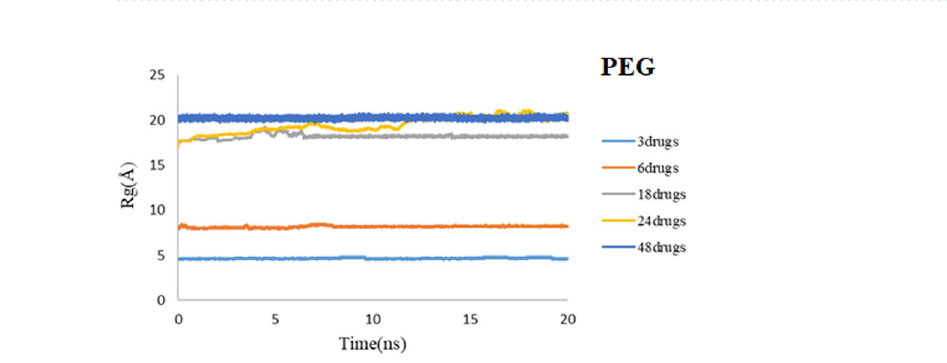
Figure 17. SASA values of 3TC-SiO 2 complex for 3, 6, 18, 24, and 48 drug molecules during 20 ns simulation time.